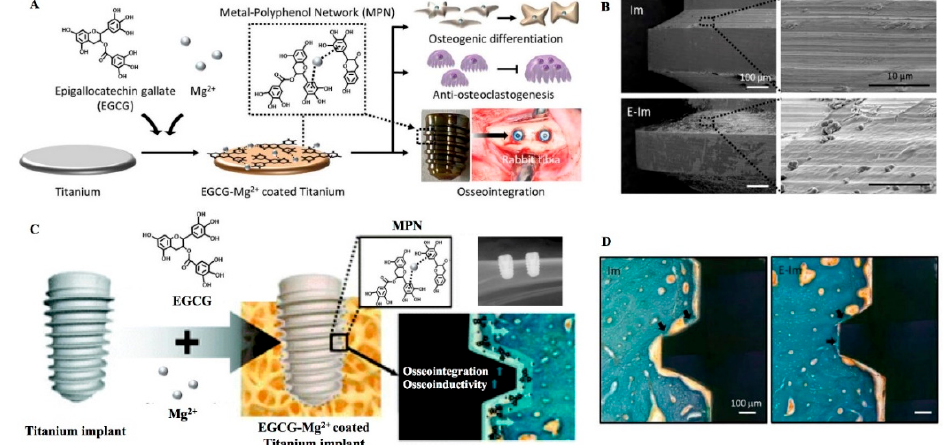
Figure 5. Surface coating of titanium alloy using Mg 2 + -polyphenol network for improved osseointegration. ( A ) Schematic diagram of EGCG-Mg 2 + coating on titanium alloy surface through the formation of a metal-polyphenol network, along with its orthopedic applications; ( B ) SEM images of the implant (Im) and EGCC-Mg 2 + coating implant (E-Im); ( C ) Schematic diagram of E-Im can improve osseointegration; ( D ) Histological sections of the total threads 4 weeks after implantation on rabbit tibia, black arrow indicates BIC area [93]. Copyright 2020. Reproduced by permission of The Royal Society of Chemistry.